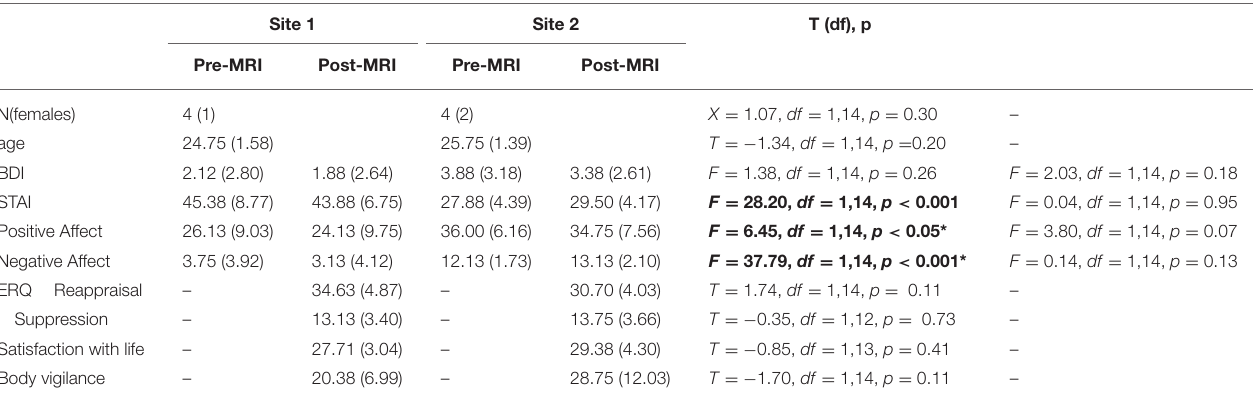
TABLE 1 | Summary of demographic and questionnaires data by Site 1 and site